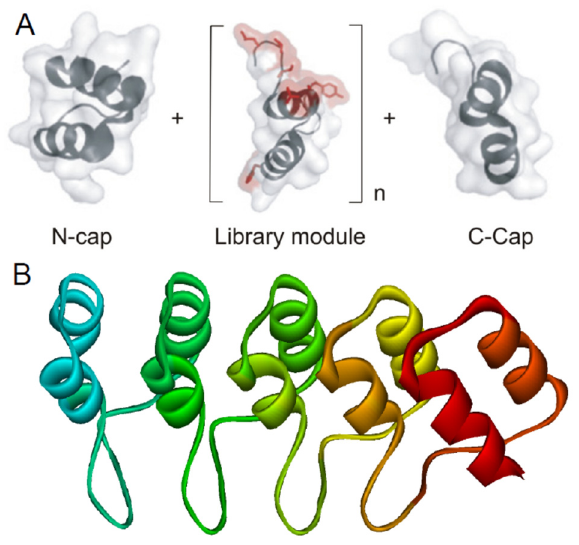
Figure 2. Scheme of the DARPin library design. ( A ) Libraries are composed of capping N- and C-terminus and a varying number of modules (n). The ankyrin repeat module consists of 33 amino acids. The red color highlights the randomized surface for potential target interaction (Figure adopted according to [53]. ( B ) Structure of NI 3 C (PDB ID: 2QYJ) as a representative example rainbow colored from the N- to the C-terminus [5].